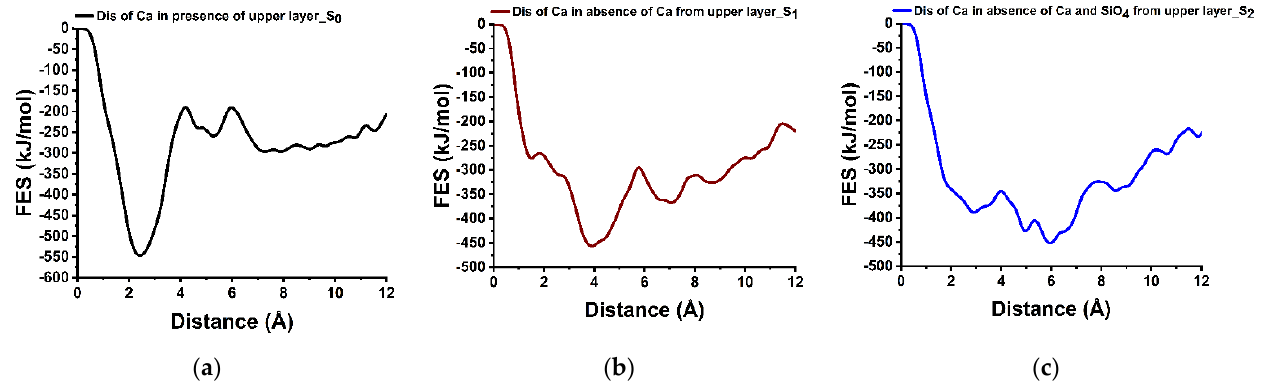
Figure 7. The representative dissolution profile of the Ca from the second layer (marked yellow in Figure 1IV, S 0 ) ( a – c ), from (100) facets of β -C 2 S in the different scenarios: before and after removal of Ca and silicate from the first layer at 298 K.